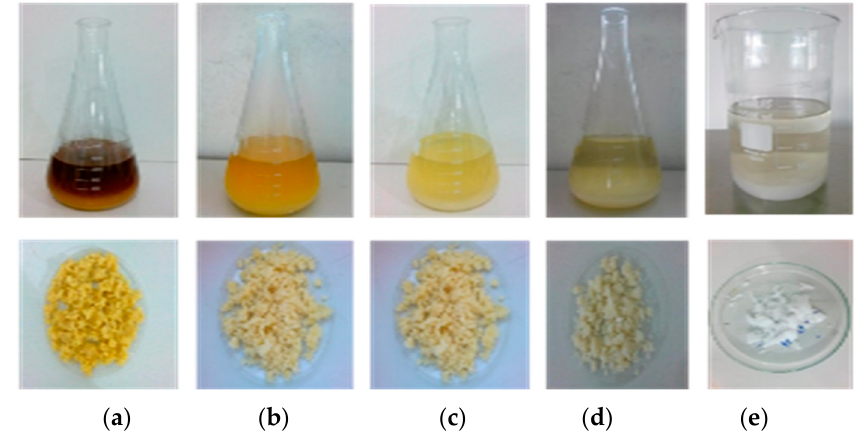
Figure 1. Cellulose pulp obtained by corncob (CC): ( a ) first wash with NaOH; ( b ) second washing; ( c ) third washing; ( d ) fourth washing; ( e ) bleaching step. Table 4. Yield and concentration of cellulose pulp and nanocrystals in the di ff erent lignocellulosic sources. Lignocellulosic Source